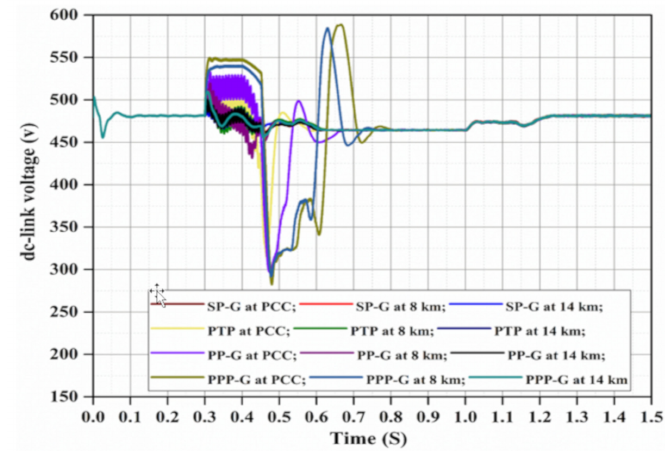
Figure 10. Variation of the dc-link voltage under grid fault conditions at different distances away from the PCC.